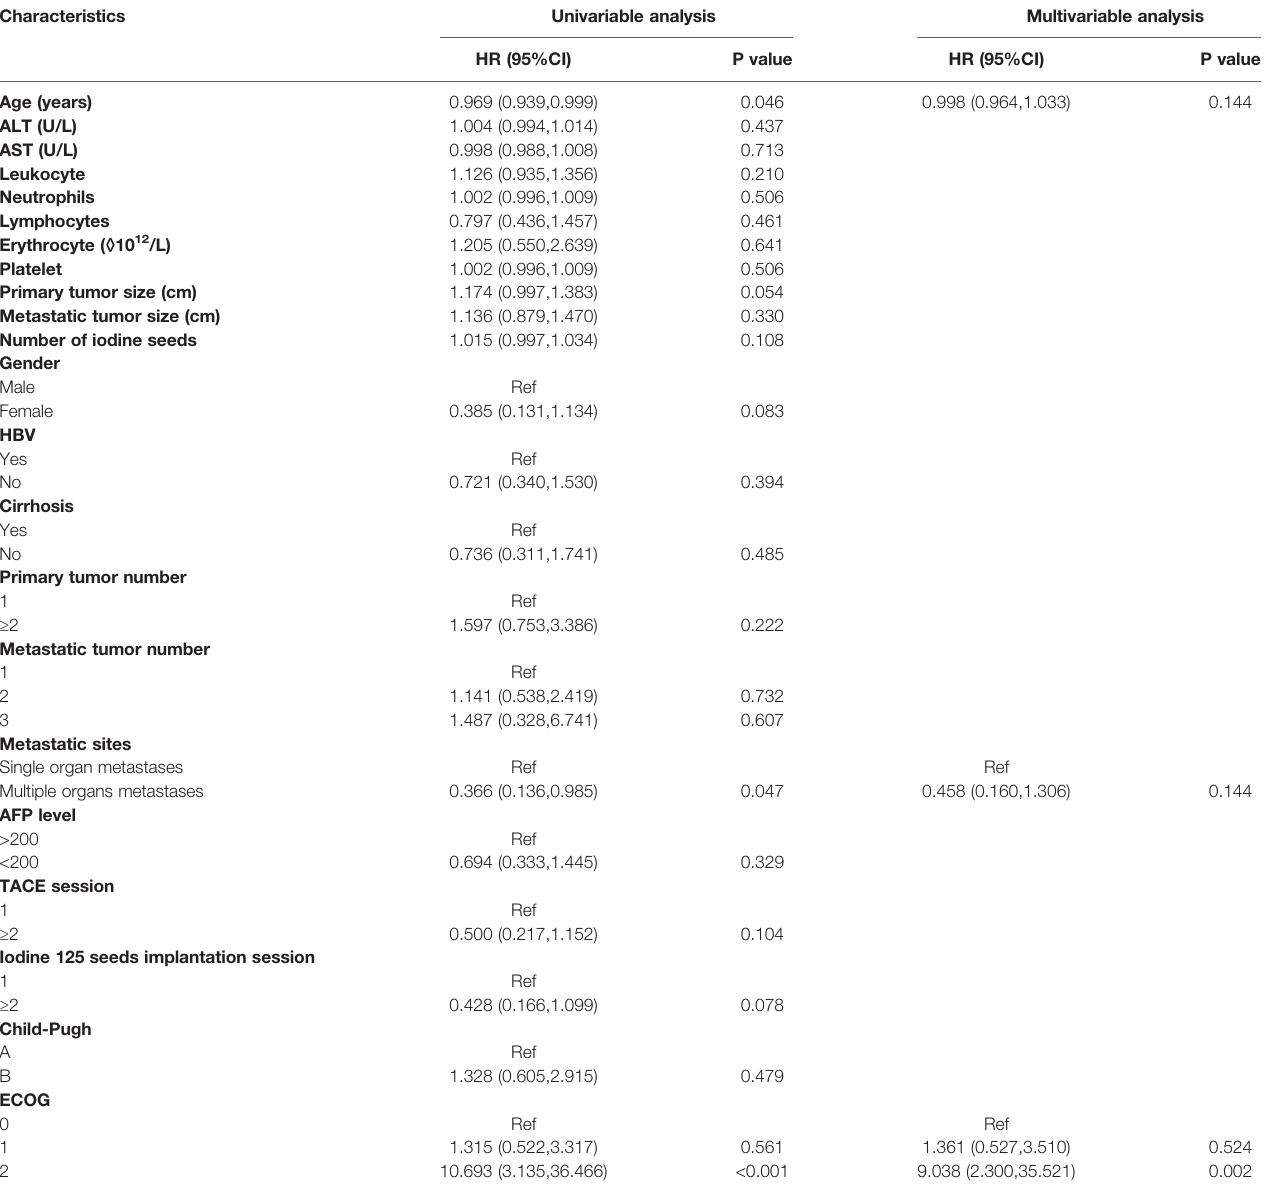
TABLE 4 | Univariable regression analysis and multivariable regression analysis for